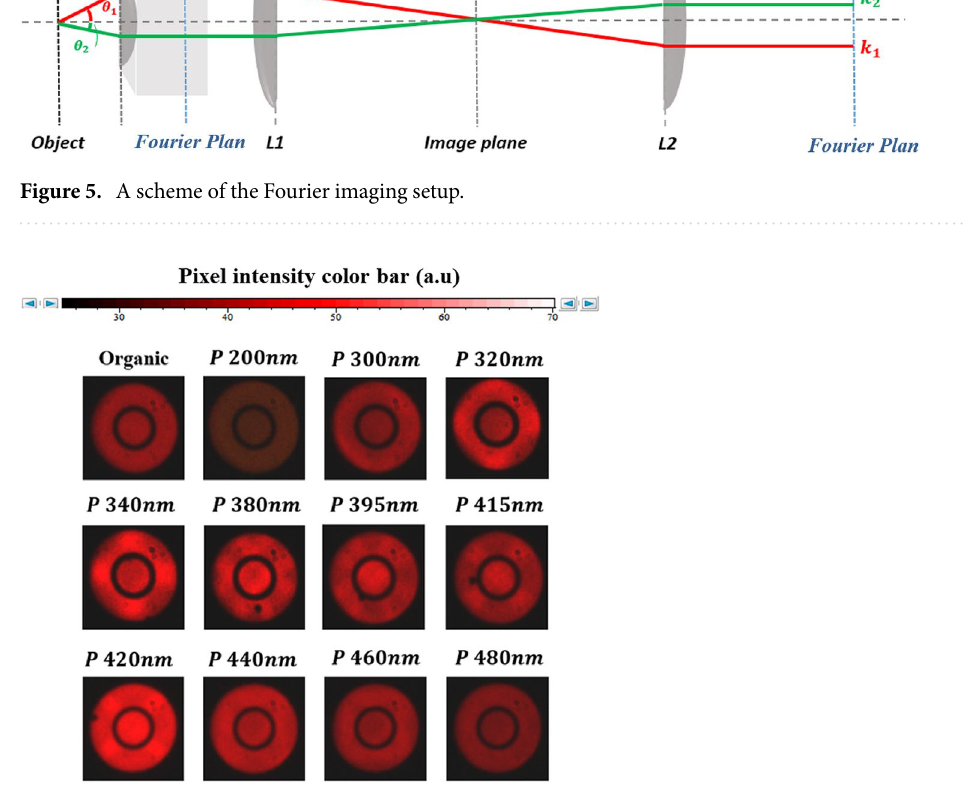
Figure 6. Fourier imaging of organic molecules optically pumped on top of metallic nanoparticles arrays of various